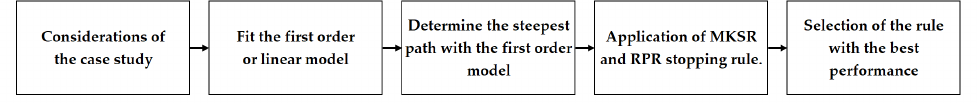
Figure 1. Flow chart for the proposed method of the manuscript from the consideration of the case study to the selection of the rule with the best